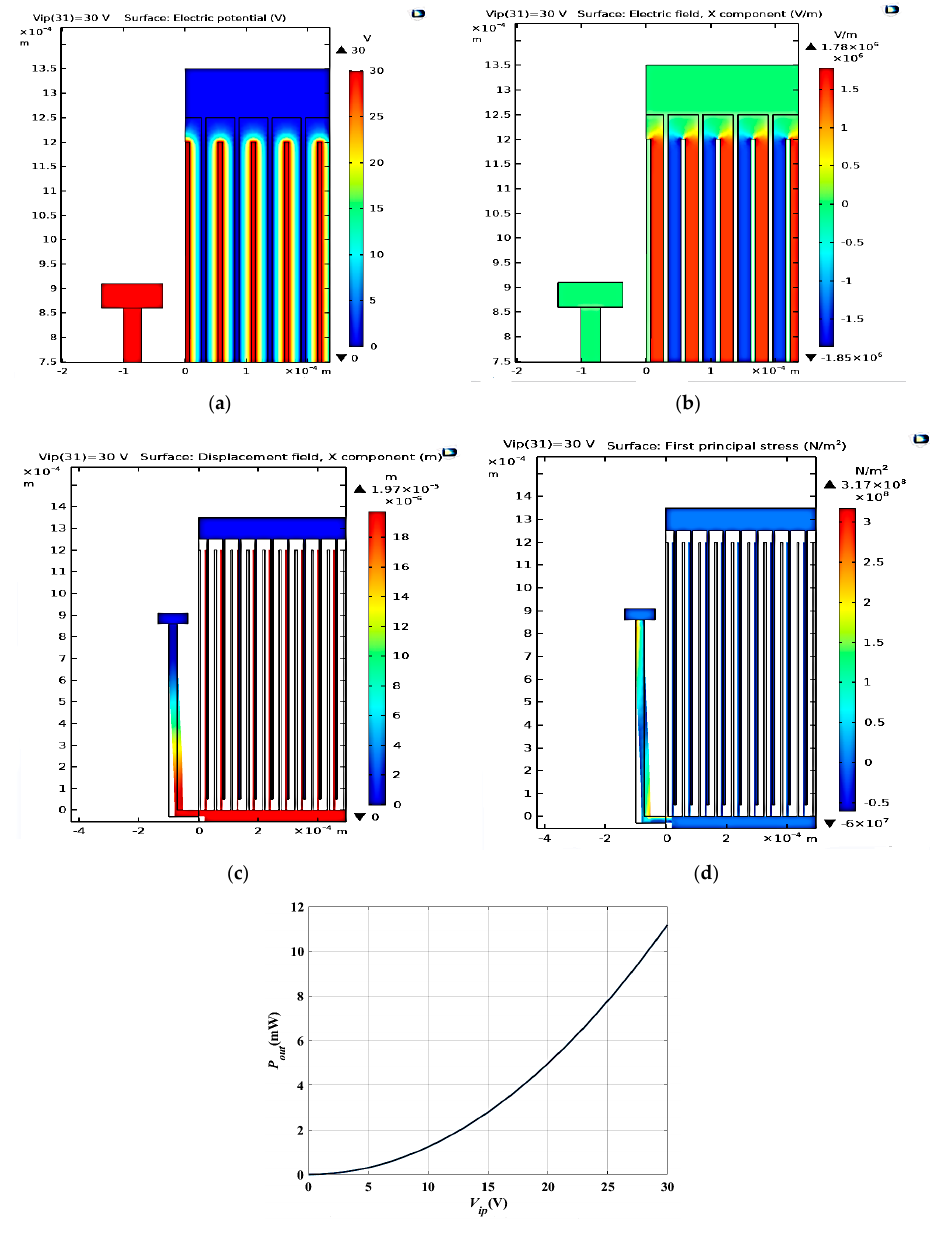
Figure 13. ( a ) Electric potential distribution, ( b ) electric field distribution, ( c ) converter displace- ment due to the input vibration signal, ( d ), stress analysis, and ( e ) P out at different values.